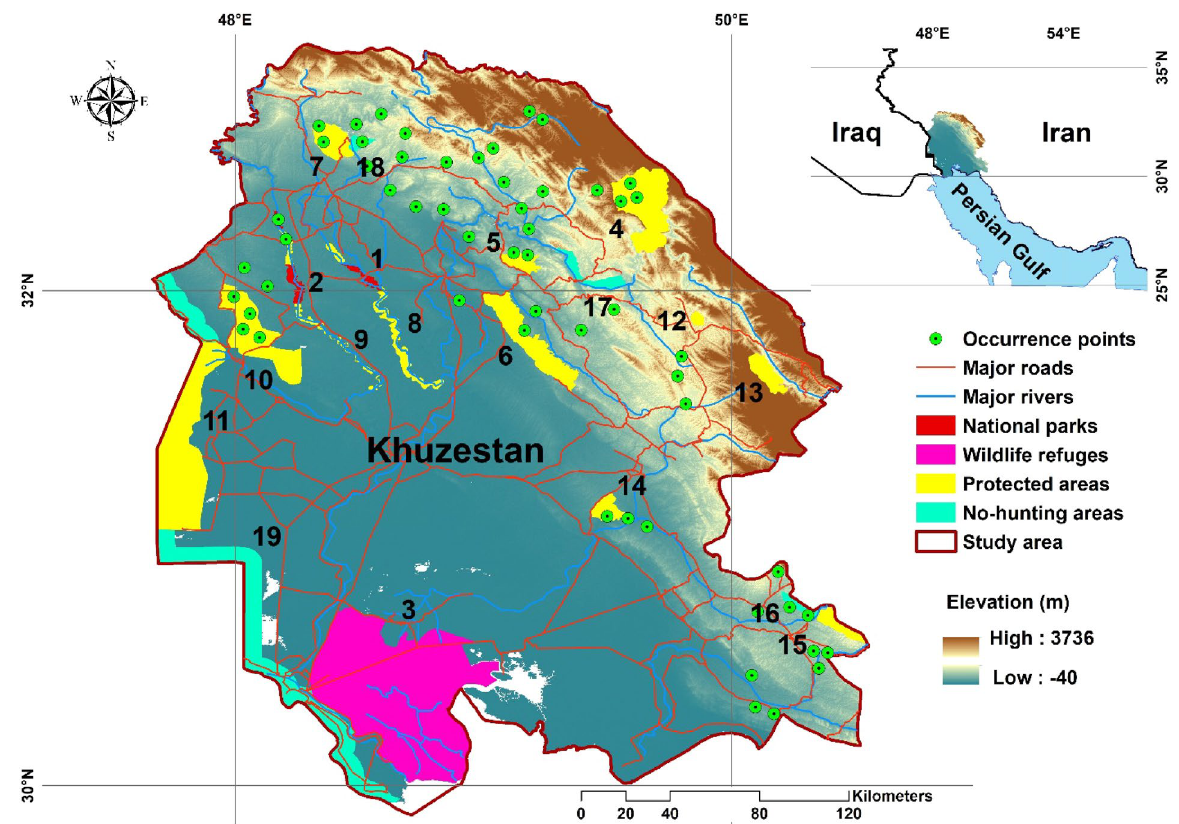
us/ arcgis/ produ cts/ arcgis- pro/ resou rces) was used to generate the